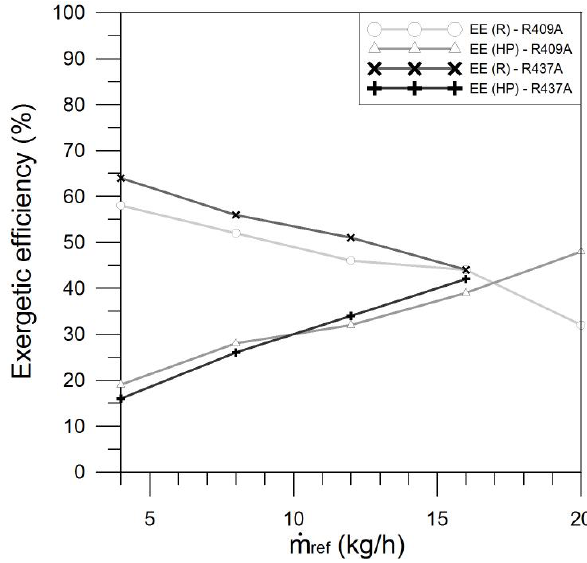
Figure 13: Effect of refrigerant flow rate on η (Group B of